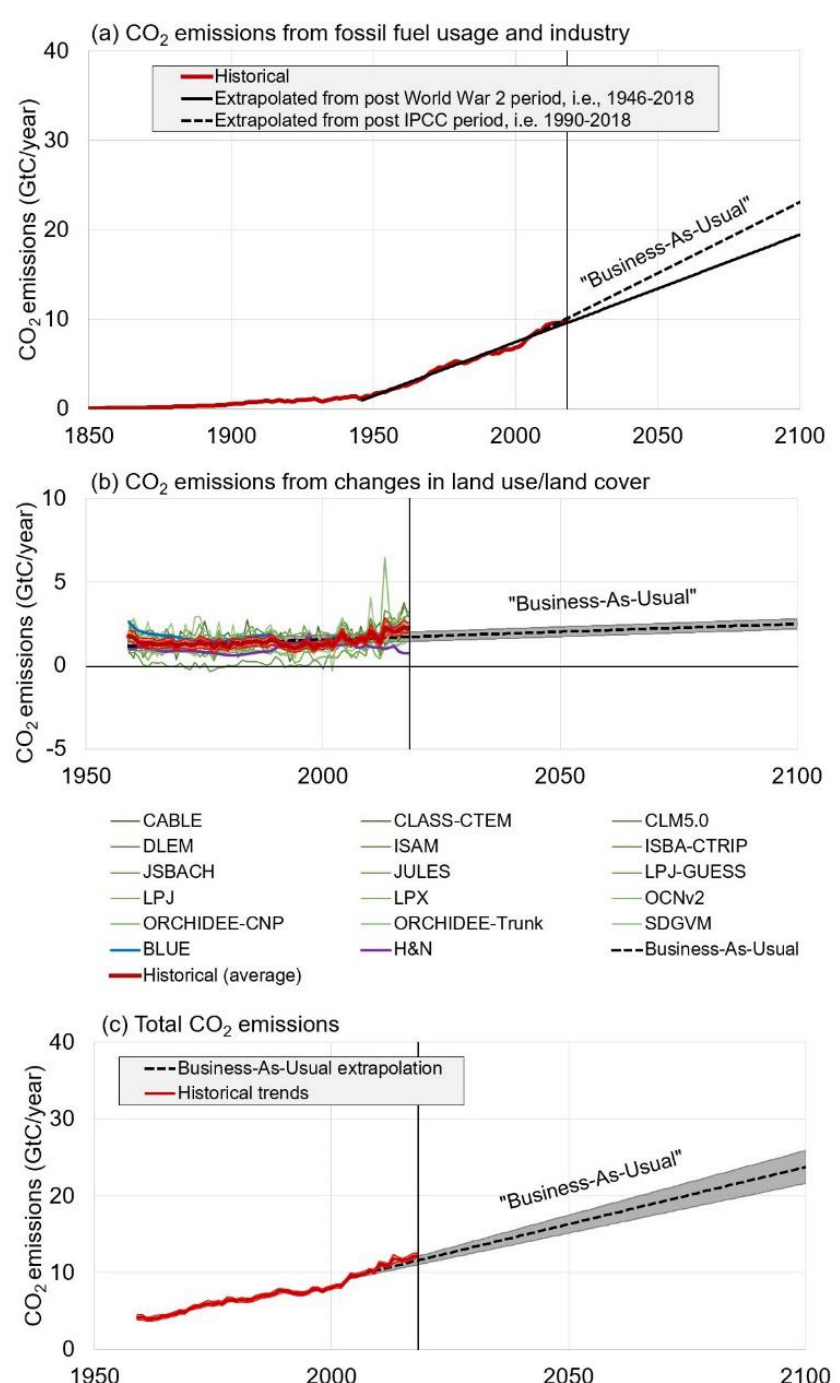
Figure 1. Historical and projected “Business-As-Usual” CO 2 emissions for: ( a ) fossil fuel and industry usage; ( b ) changes in land use / land cover; ( c ) the sum of both components. The horizontal axes correspond to years. Each of the plots for the historical period in ( b ) represents a di ff erent estimate of the CO 2 emissions since 1959, as compiled by the Global Carbon Budget project. The acronyms of these estimates are provided in the legend below ( b ), but for further details on each of these estimates, we refer the reader to Friedlingstein et al. (2019) and references therein. However, for the analysis in this paper we will use the mean ± twice the Standard Error of all these estimates, which is shown with a thick solid red line (with light red envelope).